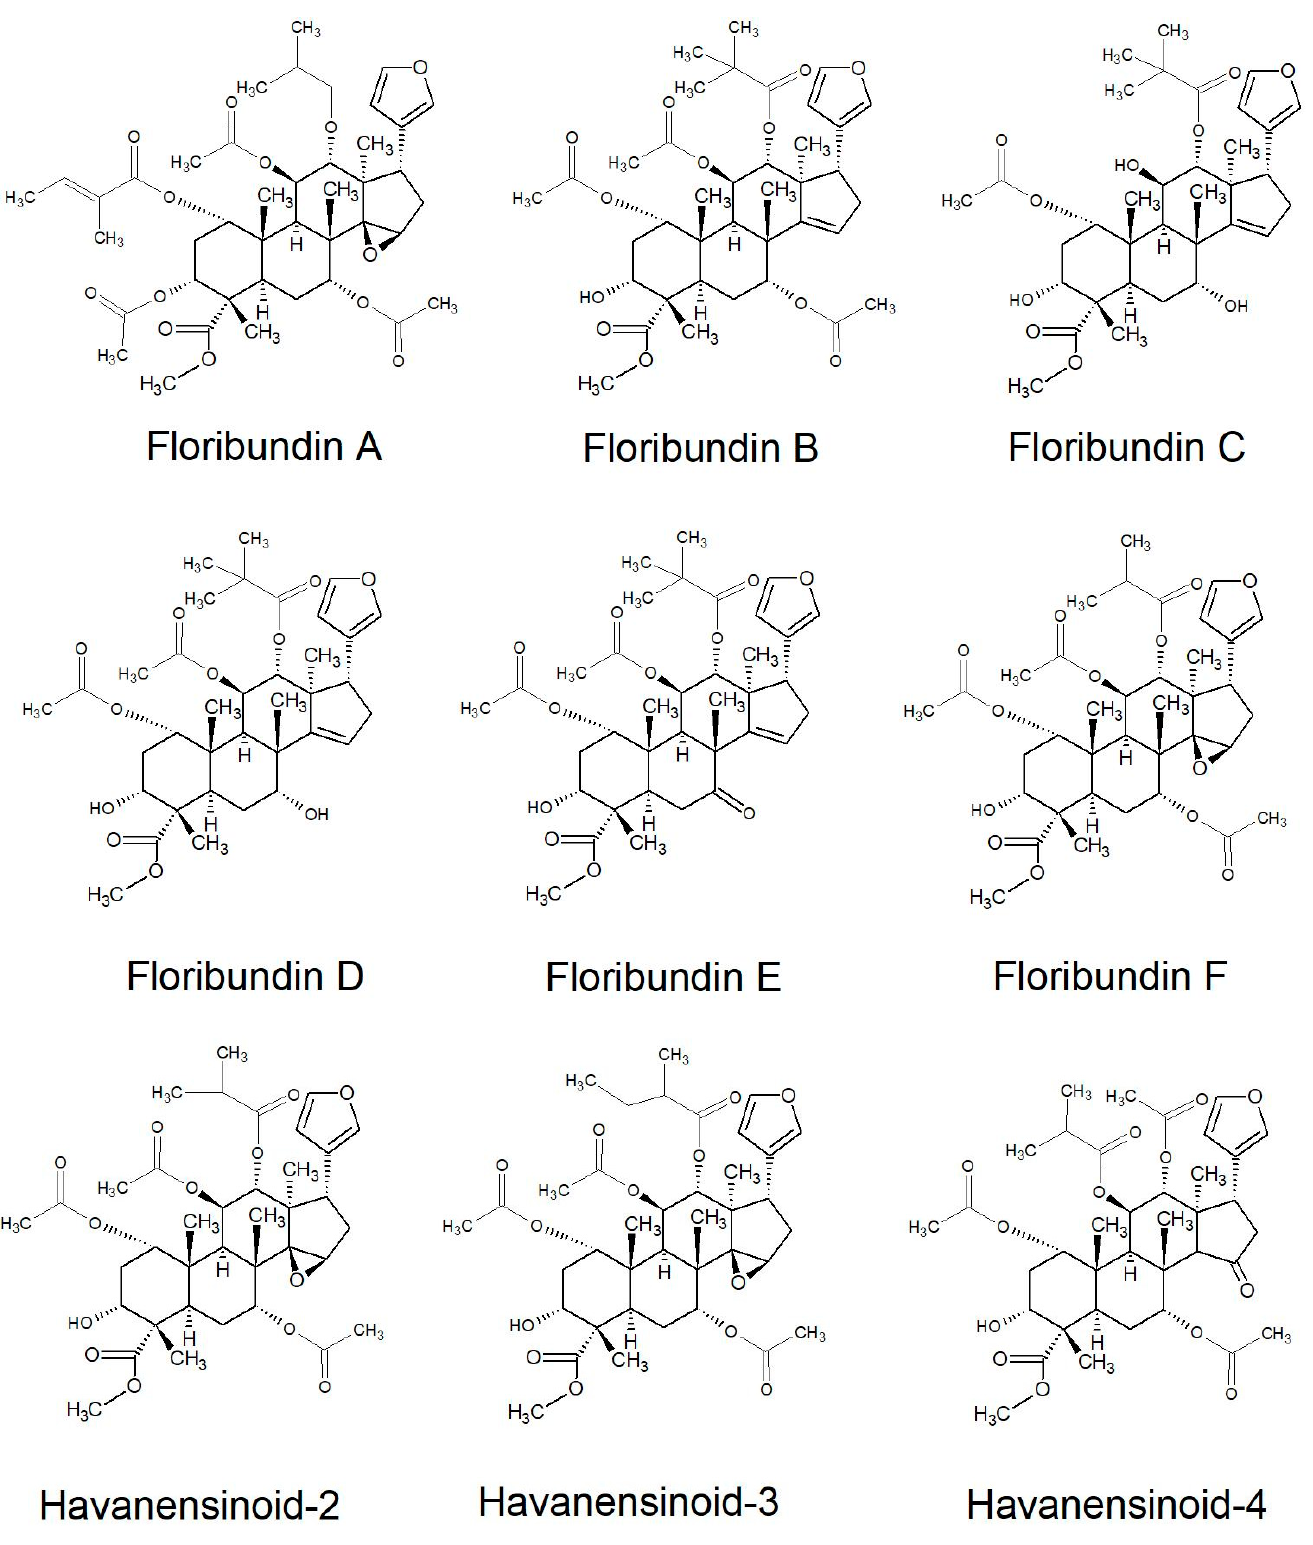
Figure 10. Floribundin and Havanen series of limonoids reported from South African Meliaceae [121,141,142,143].